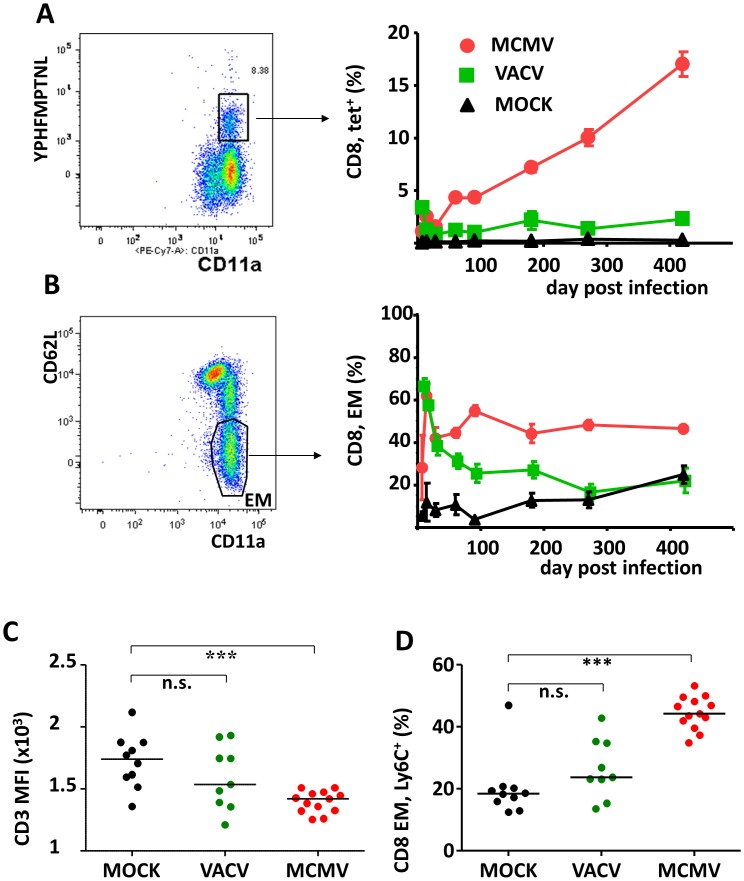
Cytomegalovirus infection irreversibly perturbs the CD8 T-cell pool.(A, B) 6 months old mice were infected with 105 PFU of MCMV or 106 PFU of VACV-IE1 and compared to untreated controls. Blood leukocytes were stained for CD3, CD4, CD8, CD11a, CD62L and YPHFMPTNL-L(d) tetramers and analyzed by flow cytometry. (A) CD8 T-cells were gated on tetramer+ CD11a+ gate as indicated in the representative plot on the left and group means (+/− SD) at 7, 14 28, 60, 90 180, 270 and 420 days post infection are connected. (B) The same cells as in panel A were gated on a CD62L−CD11a+ gate to identify EM cells (plot on the left) and group means (+/− SD) for indicated days are connected. (C) At 9 months post infection, we gated CD8+CD4− lymphocytes and compared the surface TCR expression, defined as the mean fluorescence index (MFI) of CD3, in the MCMV, VACV and mock infected mice. Symbols indicate individual mice, horizontal lines are medians. n.s. – p>0.05; *** - p<0.001 according to Bonferroni statistical comparison. (D) At 9 months post infection, the frequency of activated (Ly6C+) cells in the CD8 EM lymphocytes of MCMV, VACV or mock infected mice was compared by Bonferroni statistical comparison. Symbols indicate individual mice, horizontal lines are medians. n.s. – p>0.05; *** - p<0.001.